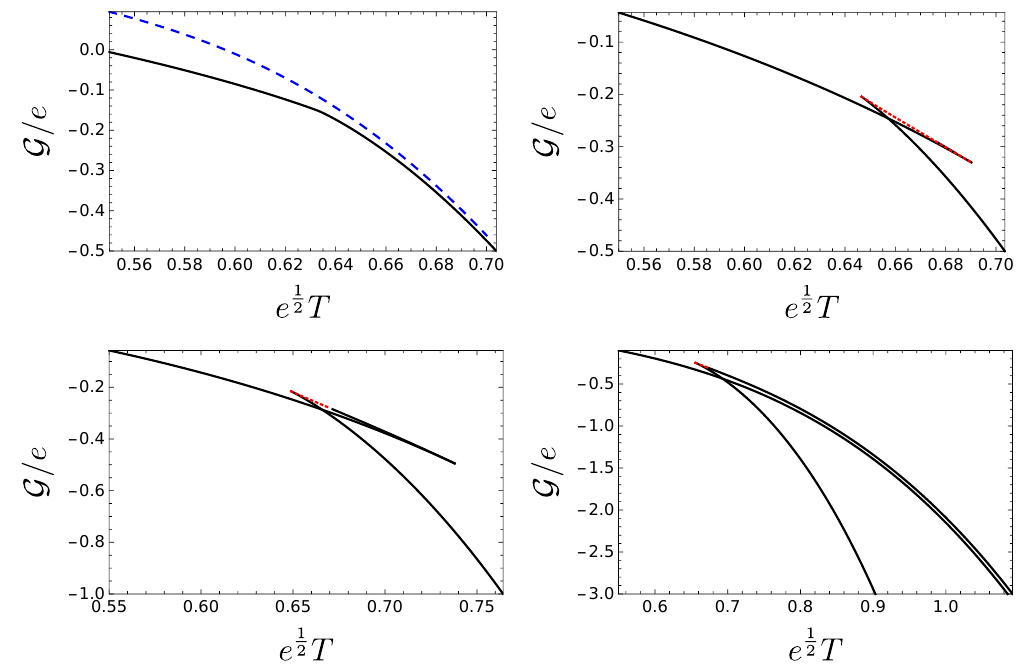
Figure 4 . Free energy in (cid:12)ve dimensions . Top left : plot of the Gibbs free energy for P = P c (solid, black curve) and for P (cid:25) 1 : 21 P c (dashed, blue curve). Top right : plot of the Gibbs free energy for P (cid:25) 0 : 96 P c . Bottom left : plot of the Gibbs free energy for P (cid:25) 0 : 95 P c . Bottom right : plot of the Gibbs free energy for P (cid:25) 0 : 92 P c . In each plot, the dotted, red lines indicate portions of the